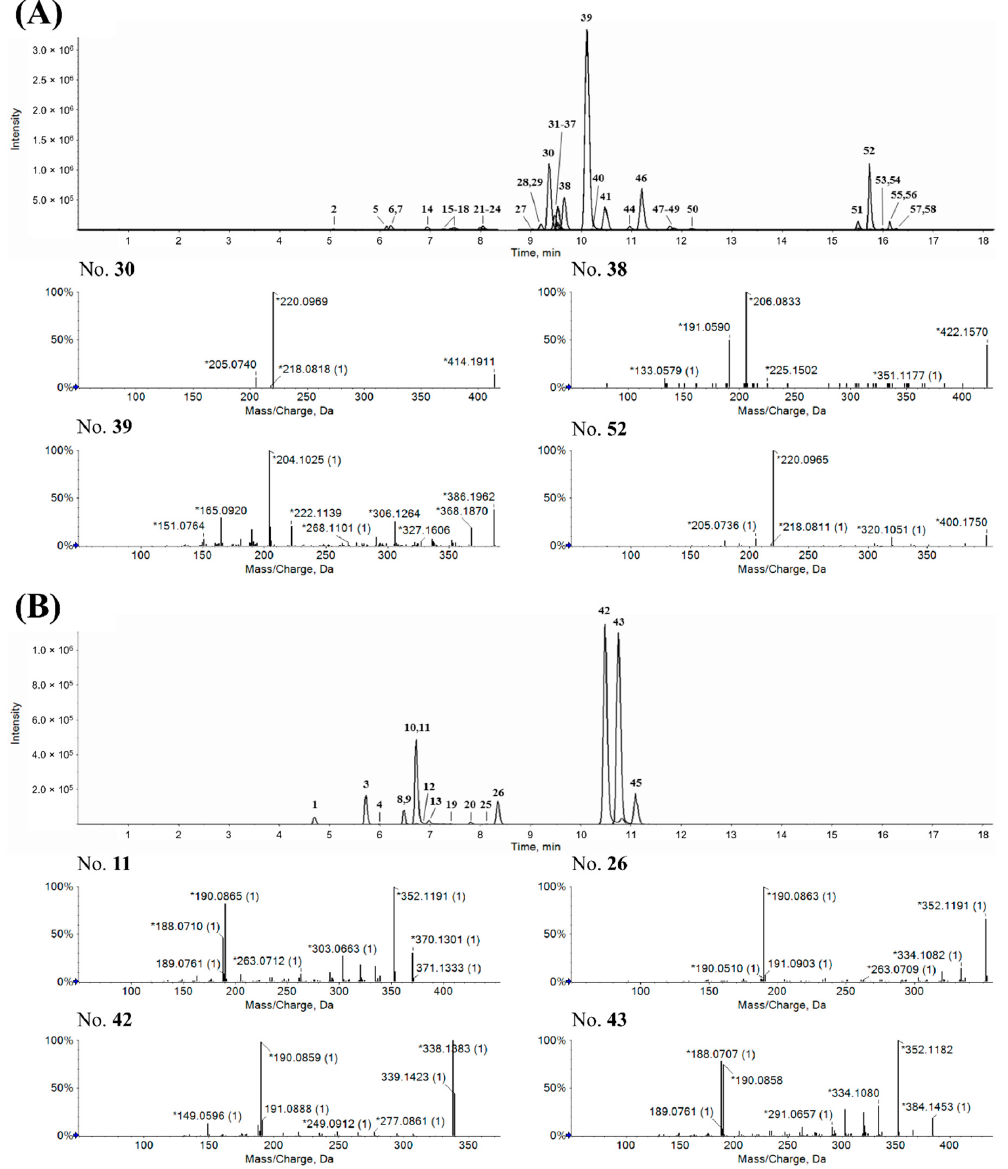
Figure 2. Representative extracted ion chromatograms of P. nudicaule ( A ) and P. rhoeas ( B ) based on clustered alkaloids. Specific metabolites of each species were numbered according to their retention times, and the fragmentation patterns of major peaks are presented.